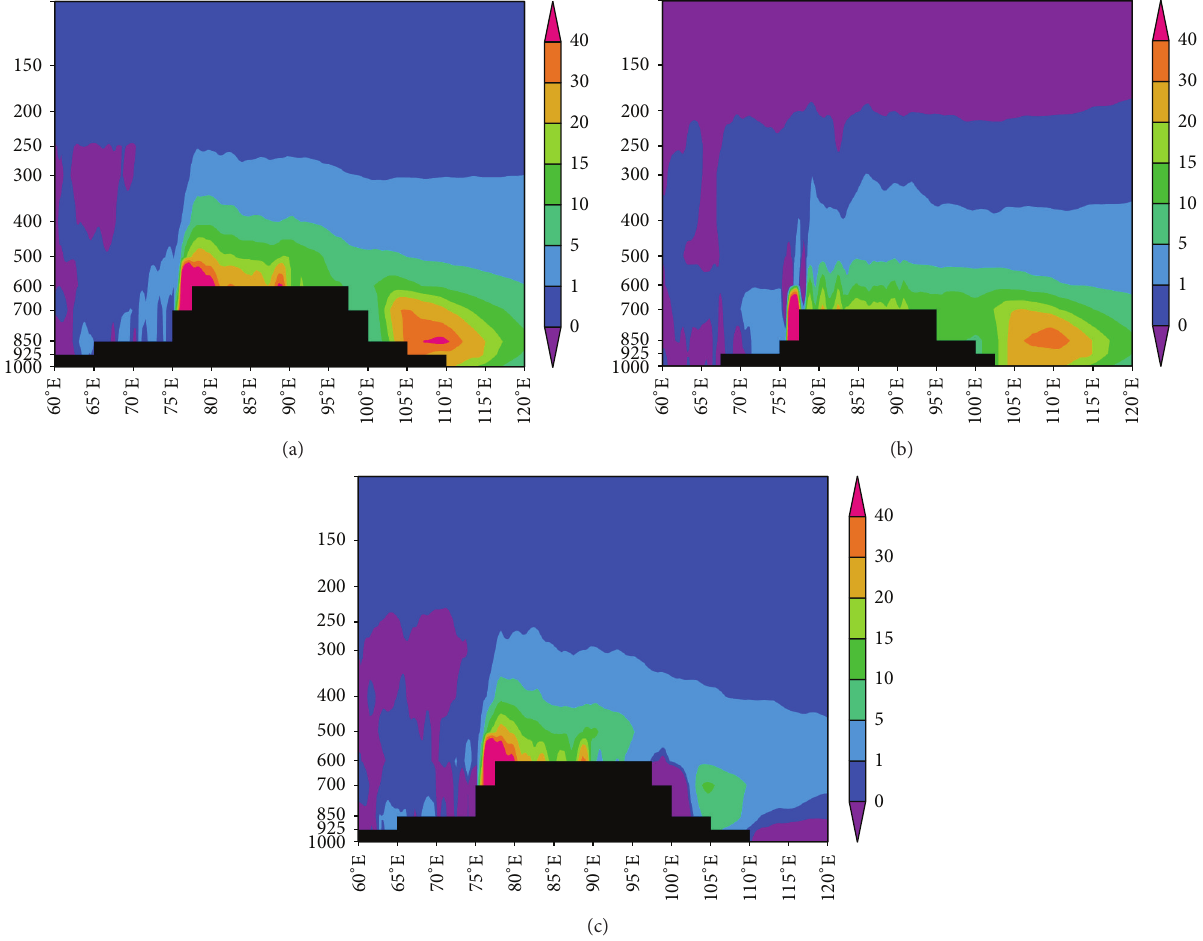
Figure 8: Longitude-height (32 ∘ –37 ∘ N) DMR ( 𝜇 gkg −1 ) changes between different experiments in spring: (a) HMD − HM; (b) LMD − LM; (c) HMD − HM minus LMD −